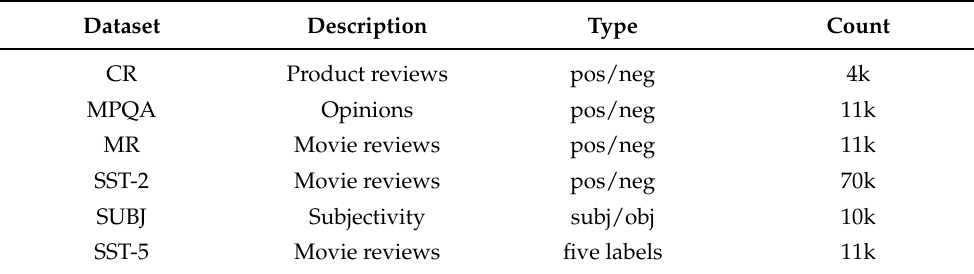
Table 1. Description of six benchmarking sentiment-classification